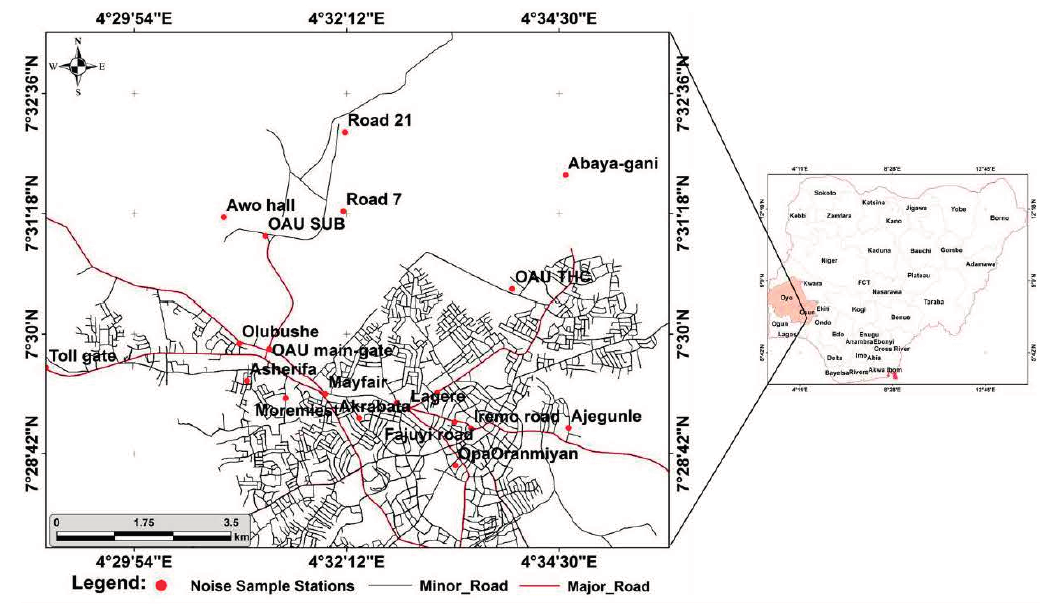
Figure 2. Map of Ile-Ife.